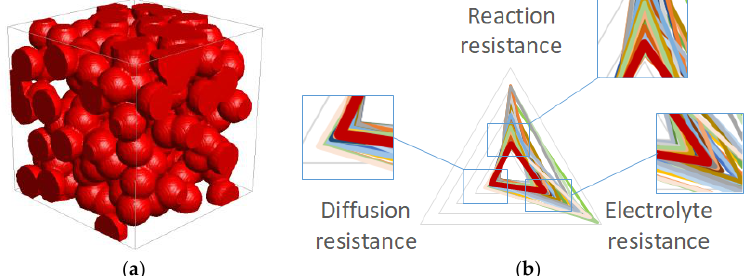
Figure 10. ( a ) Packing structure of the active material particles (50 × 50 × 50 µm 3 ), and ( b ) radar chart of each specific resistance factor in the condition of the optimized process parameters.